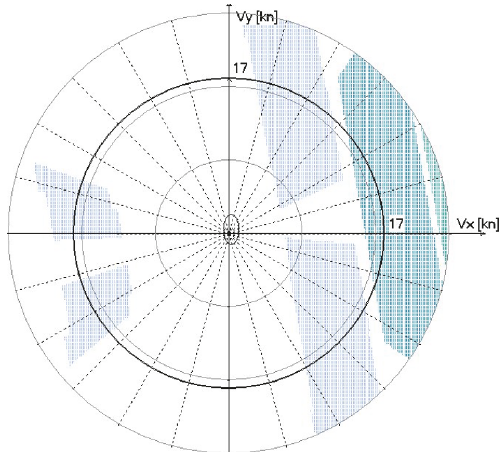
Figure 27: Sectors of own course and speed eliminated by risk of resonance (light blue) for wind of 20 [m/s] and wave from 335 ∘ .